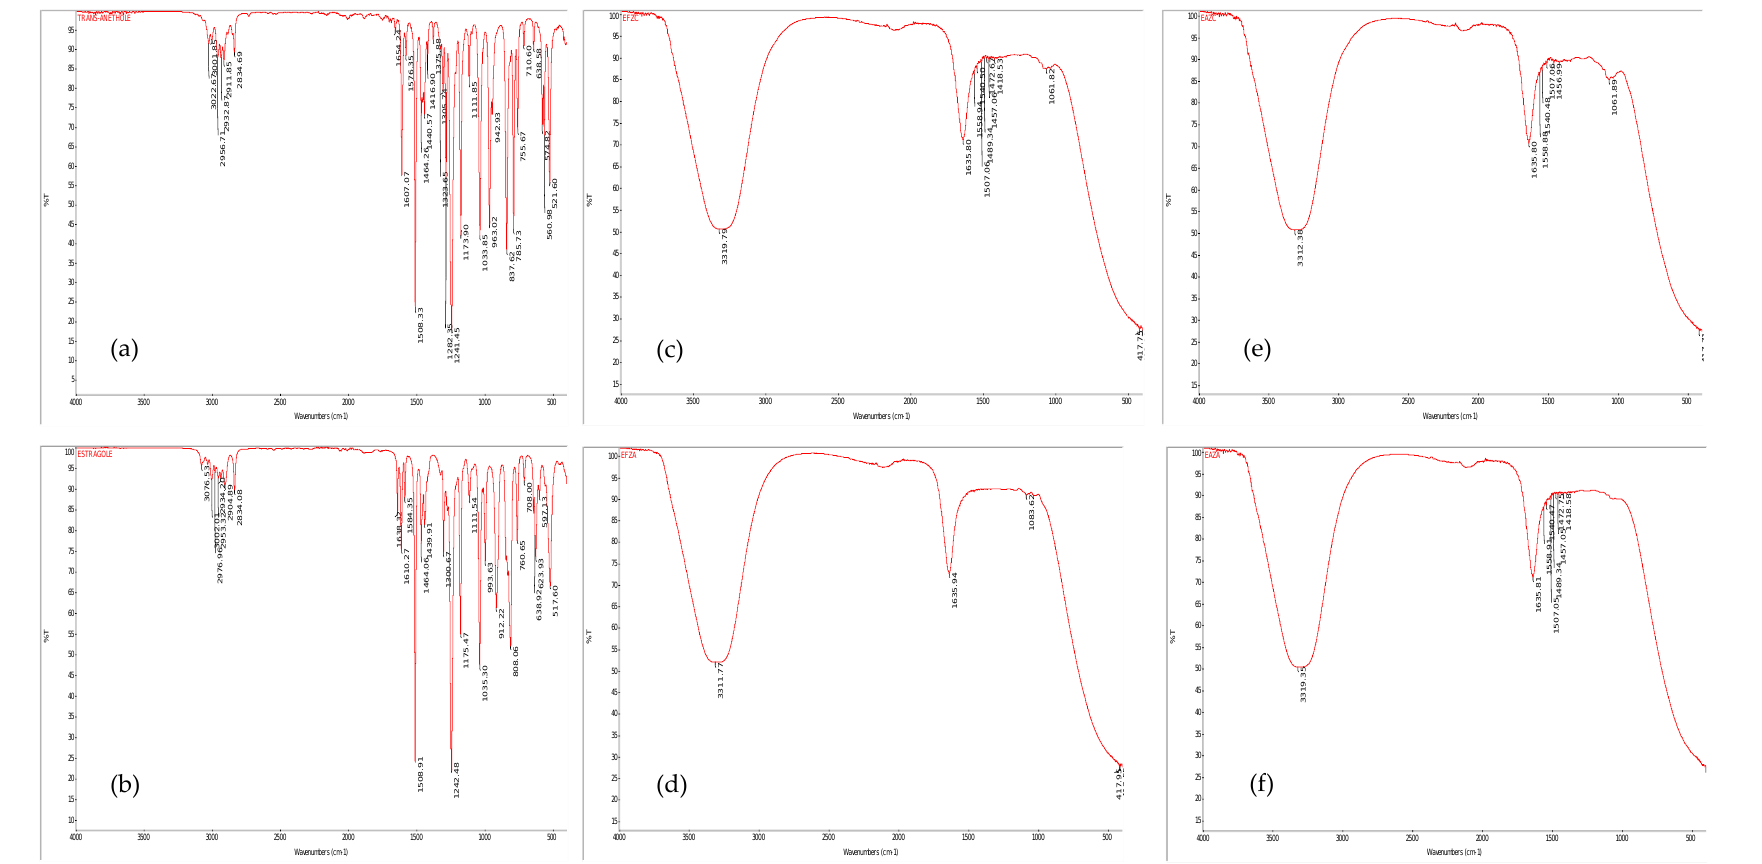
Figure 6. Fourier-transform infrared spectroscopy spectra of ( a ) standard trans-anethole ( b ) standard estragole ( c ) EFZC — zucchini puree mixed with fennel aqueous extract, processed by hot air convection; ( d ) EFZA — zucchini puree mixed with fennel aqueous extract, processed by steam convection; ( e ) EAZC — zucchini puree mixed with anise aqueous extract, processed by hot air convection; ( f ) EAZA — zucchini puree mixed with anise aqueous extract, processed by steam convection.